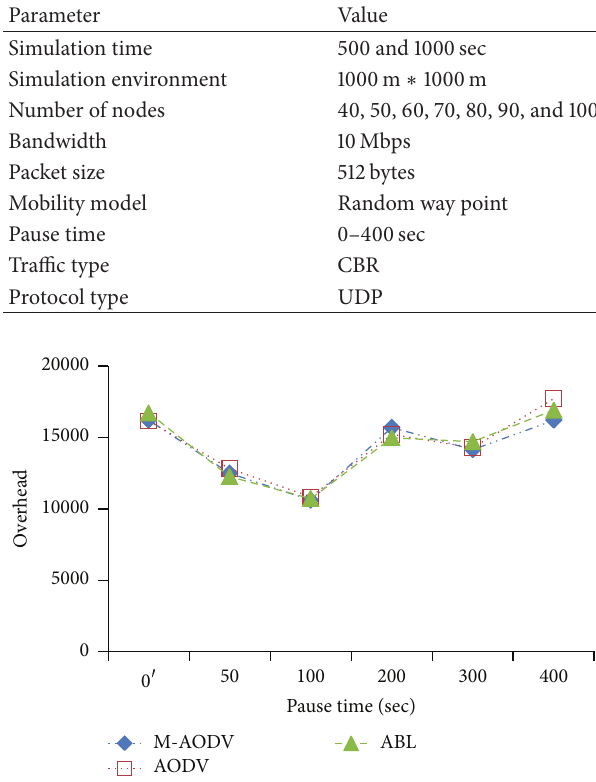
Figure 3: End-to-end delay in first scenario.